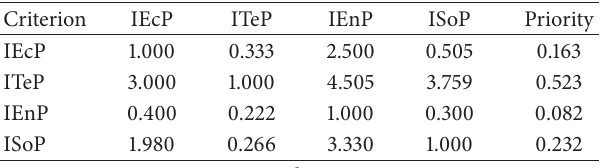
Table 6: Pairwise comparison of criteria with respect to the goal.